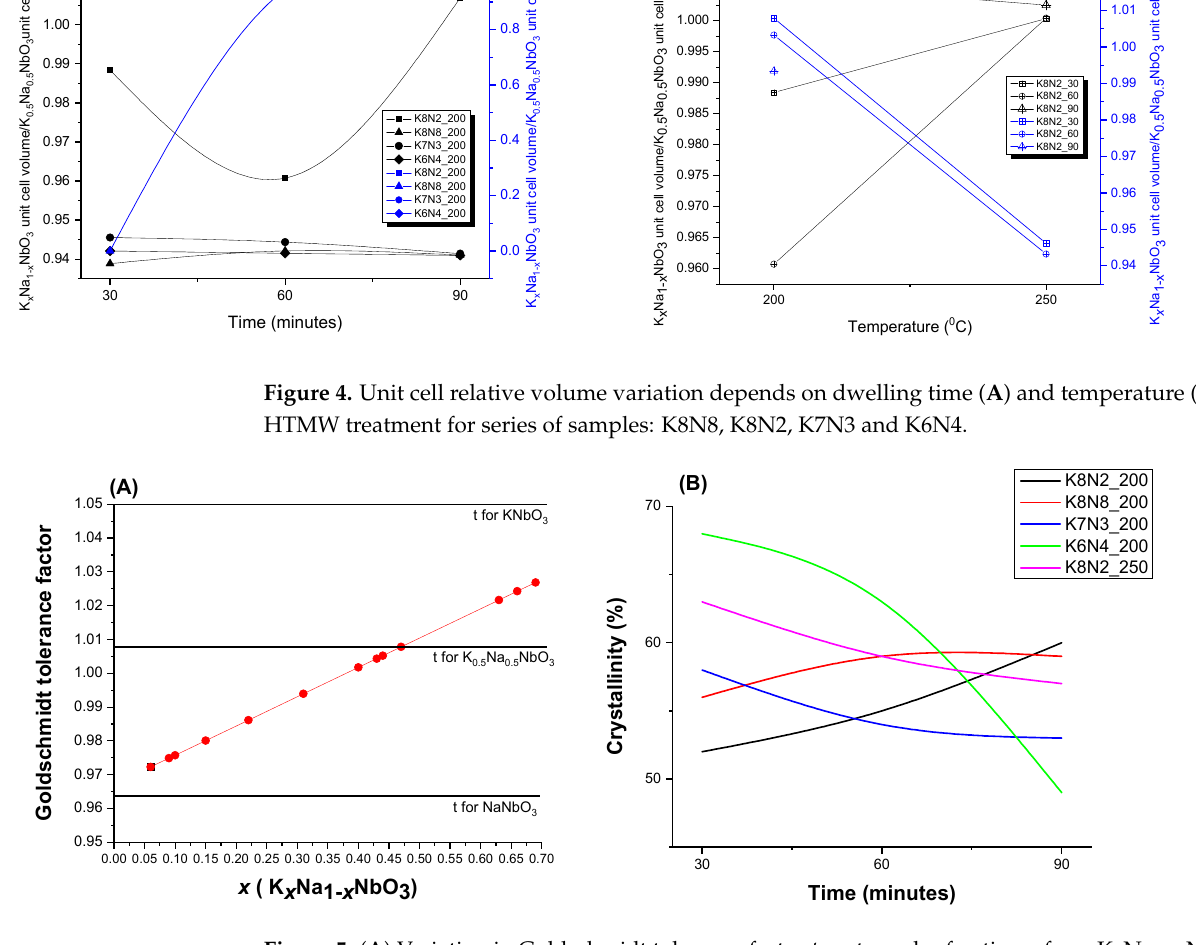
Figure 5. ( A ) Variation in Goldschmidt tolerance factor t up to molar fraction x from K x Na 1 − x NbO 3 . ( B ) Crystallinity degree for all series of powders K8N2_200, K8N2_200, K8N2_250, K7N3_200, K6N4_200 HTMW synthetized for 30–90 min.